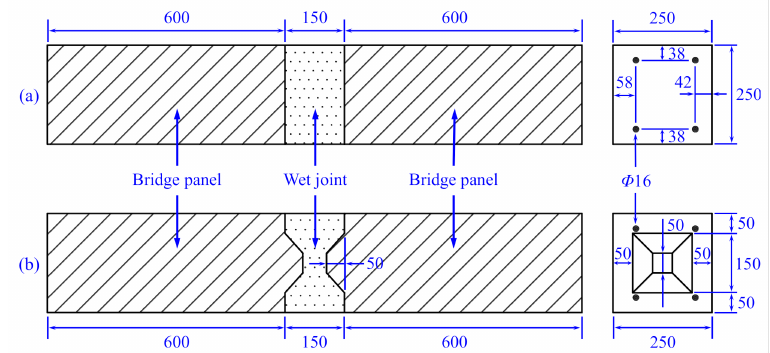
Figure 3. Detailed dimensions (unit: mm) of ( a ) S-CWJ and ( b ) S-SWJ.